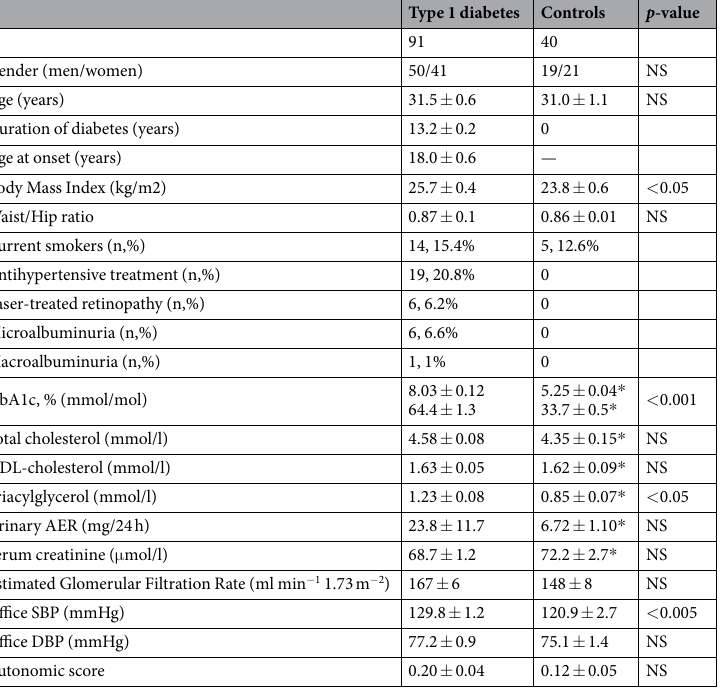
Table 1. Clinical characteristics and laboratory measurements of patients with type 1 diabetes and healthy control subjects. SBP: Systolic Blood Pressure. DBP: Diastolic Blood pressure * data obtained in 24 control